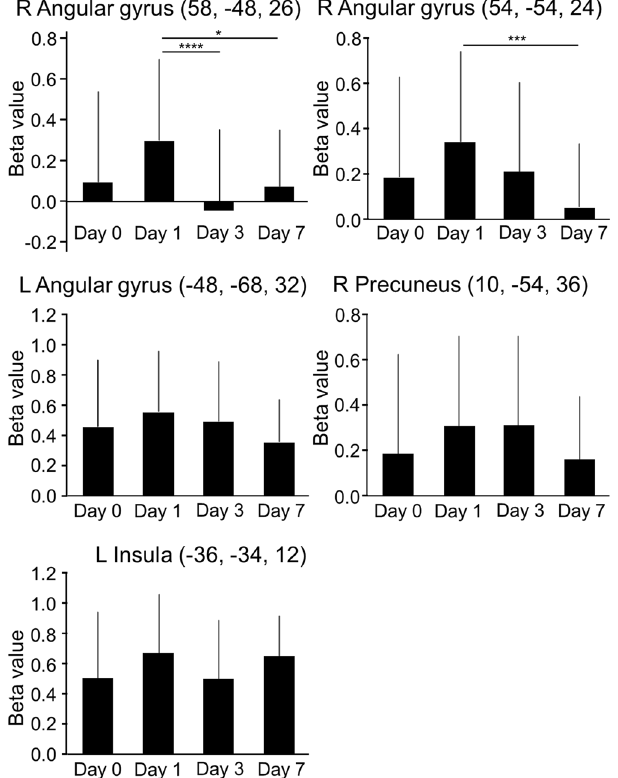
Figure 4. The beta values of the peak coordinates of the ROIs which were more significantly activated on Day 1 than on Day 3 or Day 7 (n = 27). Error bars represent standard deviation. ROI: region of interest. * P < 0.05, *** P < 0.005, **** P <